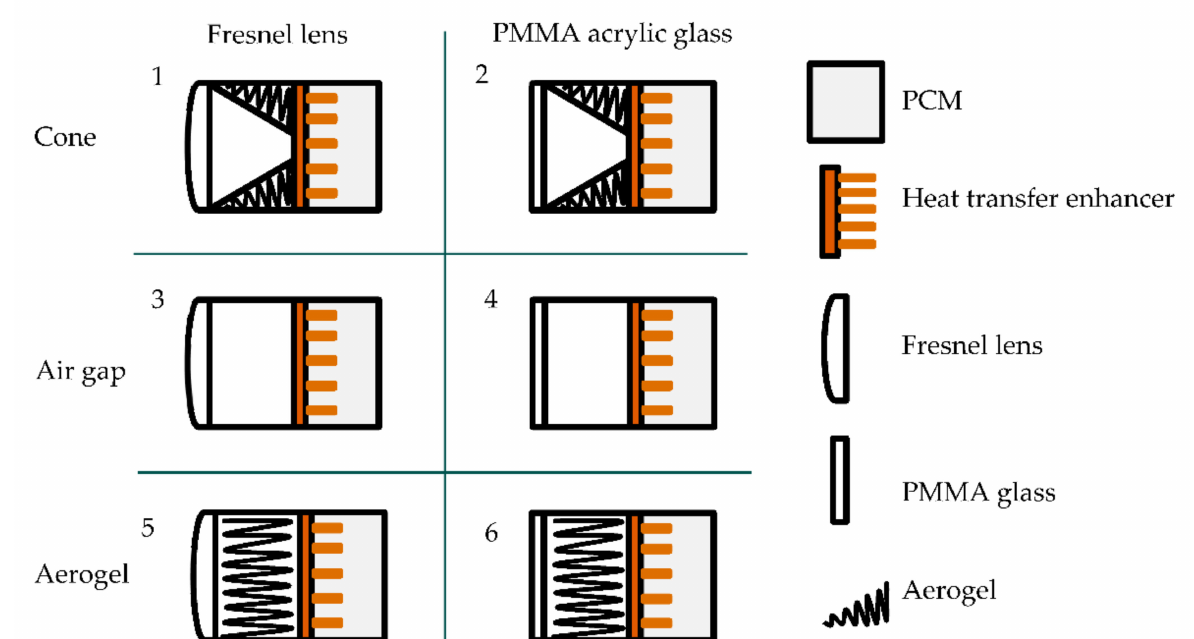
Figure 3. Schematic representation of six solar facade variations.